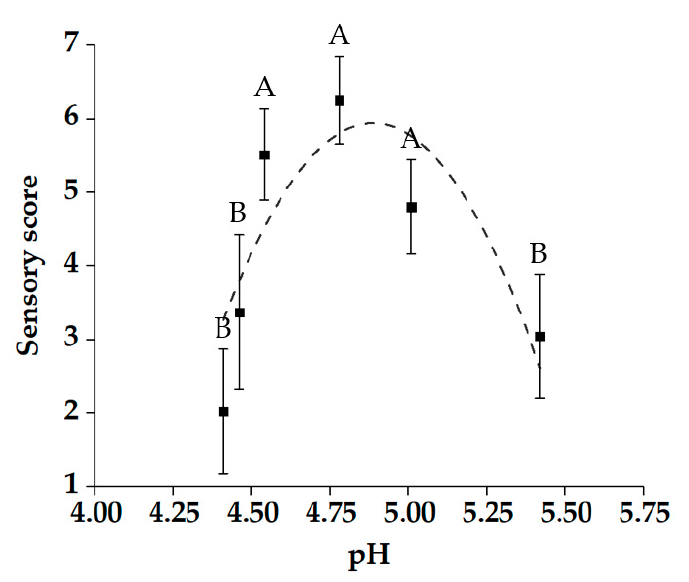
Figure 4. Principal component analysis (PCA) of Chinese steamed bread with different sourdough fermentation times: (a) 4 h; (b) 8 h; (c) 12 h; (d) 16 h; (e) 20 h; (f) 24 h. 2.2. Effects of Chemical and Biological Acidification on Textural Properties and Rheological Characteristics Chemical and biological acidification methods were compared to determine the effect of changes in pH on the texture of the steamed bread. Steamed bread produced by chemical acidification resulted in weakened hardness, chewiness, and adhesiveness as compared to those proofed with sourdough (Figure 5); this indicates that the final pH value of proofed dough is not the key factor for textural improvement. Chemical acidification damaged the gluten network structure of the dough due to the rapid reduction in pH level during proofing. As previously reported by Kopec’ [22], sourdough fermentation involves gradual acidification through microbial metabolism. The